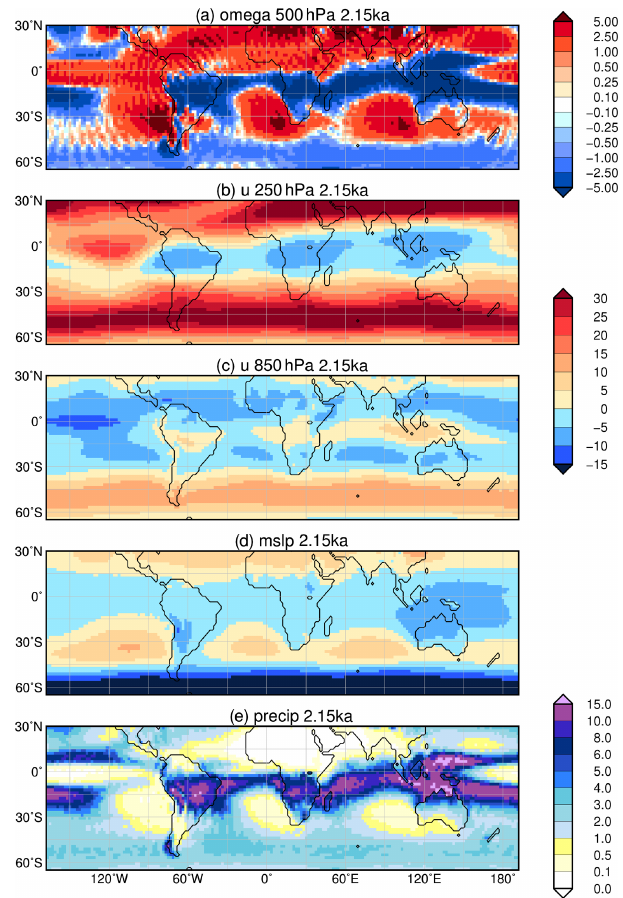
Figure B4. Simulated DJF mean climate at 2.15ka, i.e. (a) vertical velocity (omega) in 500hPa (10 − 2 ms − 1 ) with blue colour show- ing uplift; (b) upper-tropospheric zonal wind ( u ) in 250hPa (ms − 1 ) with blue colours indicating easterly wind; (c) low-level zonal flow ( u ) in 850hPa (ms − 1 ); (d) mean sea level pressure anomaly (hPa) to standard atmospheric mean pressure (here 1013.25hPa), with blue colours indicating low-pressure systems; and (e) mean sea- sonal precipitation (mmd − 1